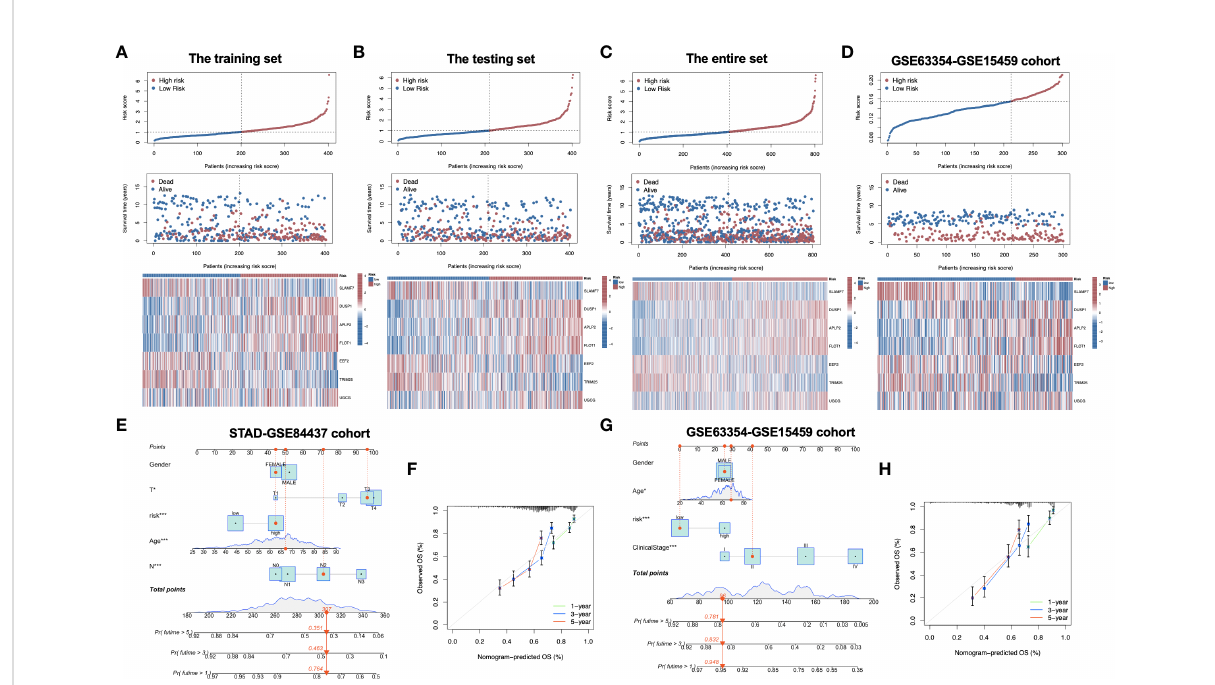
FIGURE 3 Distribution of risk score, overall survival, gene expression in the training set (A) , the testing set (B) , the entire set (C) and the external validation cohort (D) . Distribution of risk score, overall survival, and heatmap of the expression of eight signature genes in low-risk and high-risk groups is presented in the fi gure from top to bottom. (E) Nomogram for predicting the 1-year, 3-year and 5-year OS of GC patients in the entire set. (F) Calibration curves of the nomogram for predicting of 1-year, 3-year and 5-year OS in the entire set. (G) Nomogram for predicting the 1-year,